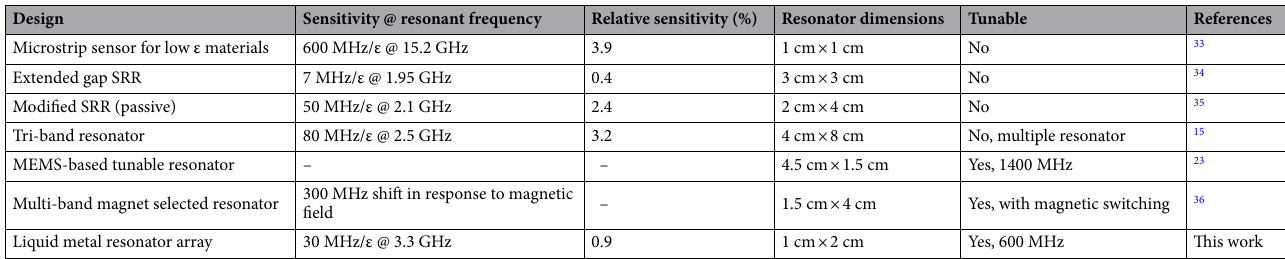
Table 1. Sensitivity comparison of state-of-the-art resonator